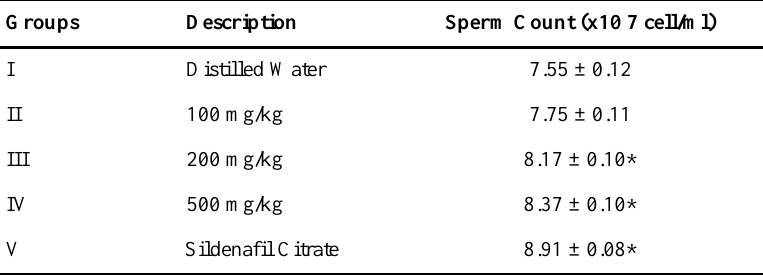
Table 1.1: Effect of MPAE on Sperm count of the male rats